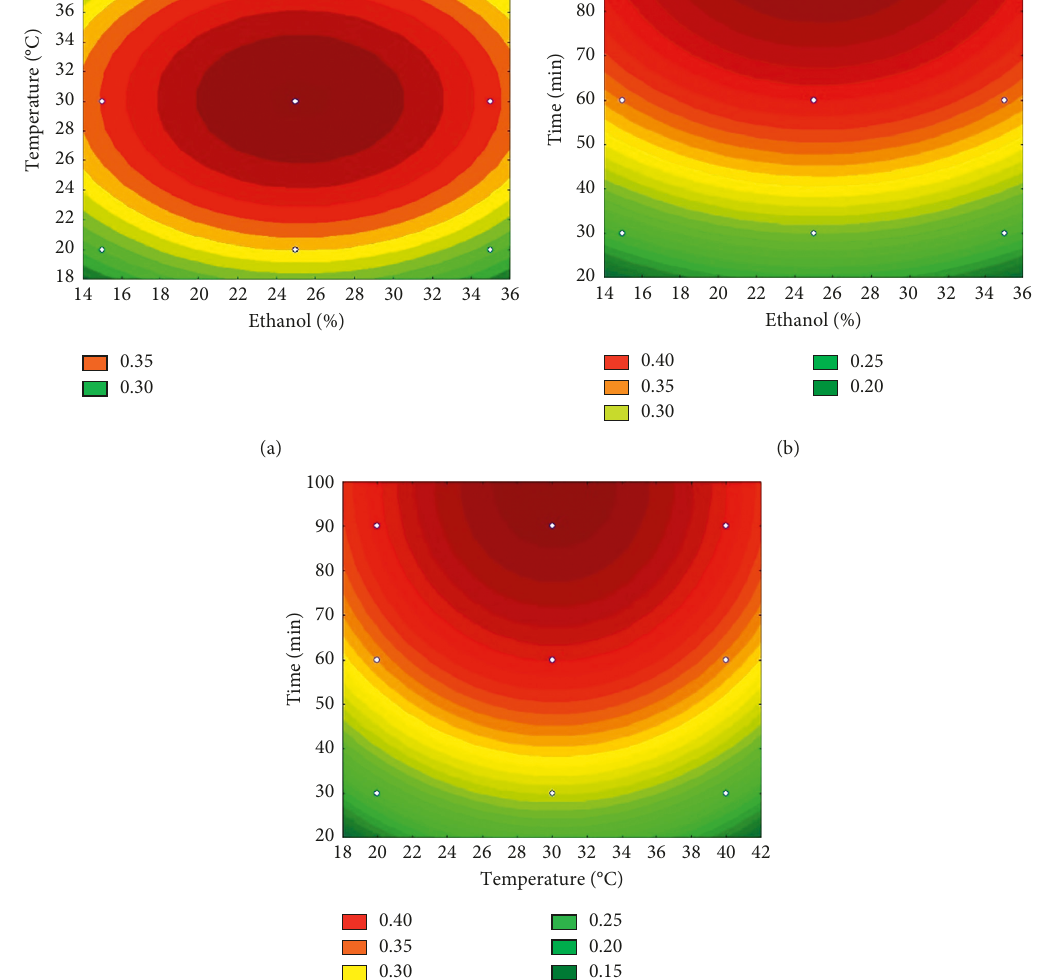
Figure 1: Response surface plot representing the effect of the variables on beta-galactosidase activity (U Aspergillus oryzae CCT